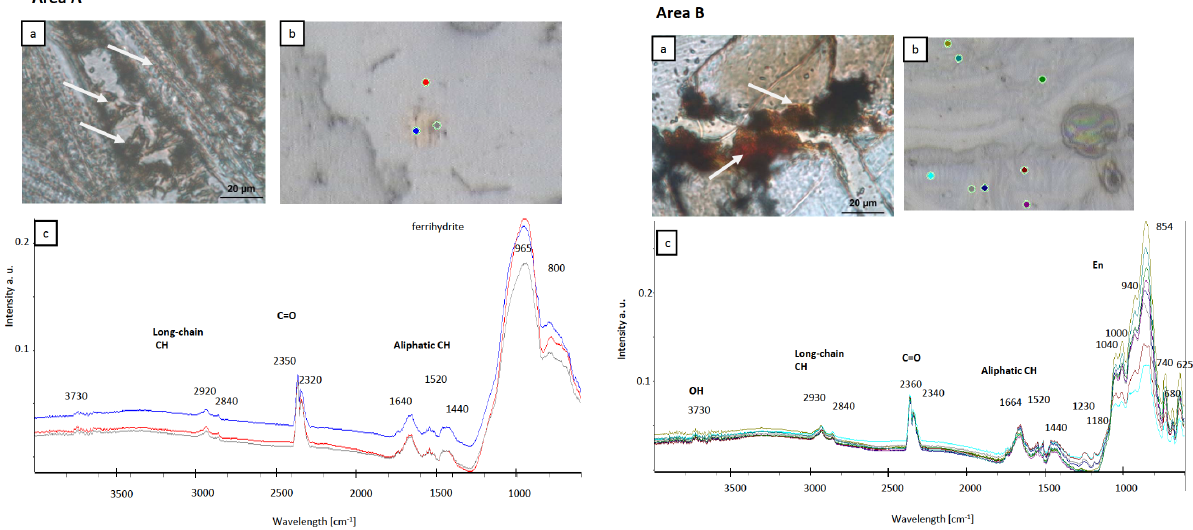
Figure 6. Area (A) a) Filamentous pearl necklace-like inner textures (marked by arrows) in shock melt pocket; Area (B): a) Microbially me- diated mobilization and mineralization of iron from opaque minerals and organic material. IR spectra of area near troilite (degradation to ferrihydrite) and pyroxene with organinc compounds of biosignatures. Area (A) and (B) b) measuring points of FTIR spectra; c) Spectra were taken in shock melt pocket. The peak positions are marked by numbers above the spectra, and vibration types are written by bold letters. Legend: